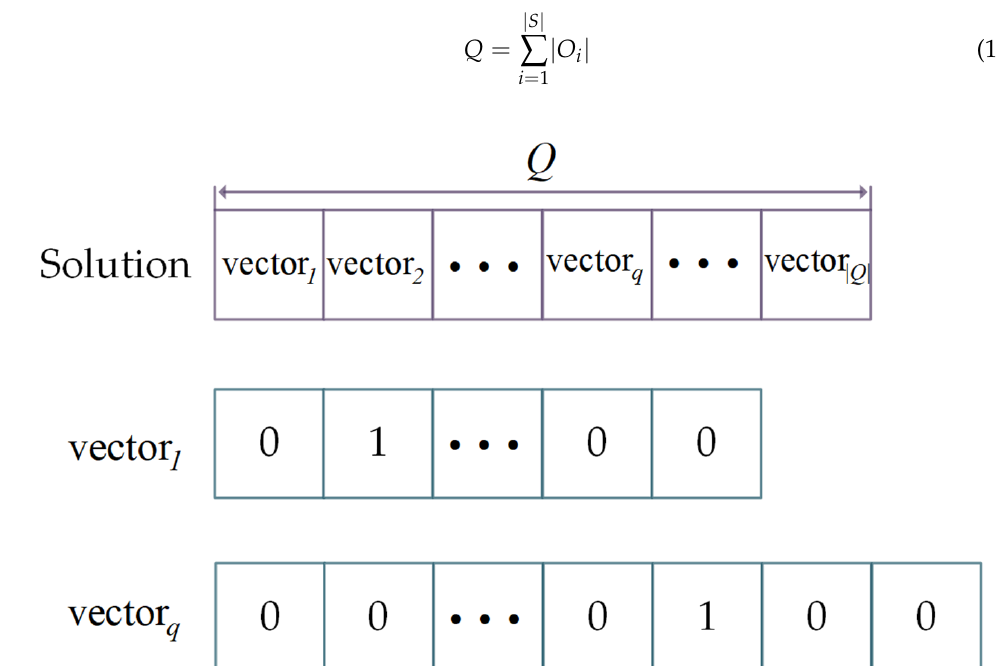
Figure 7. 0–1 Integer vector coding method.